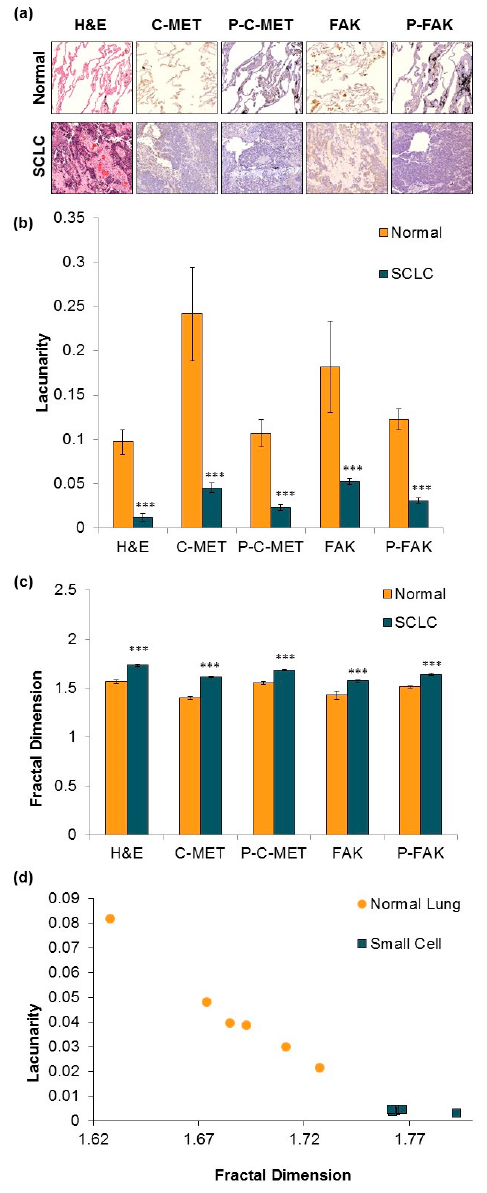
Figure 2. Immunohistochemistry images and fractal analysis of SCLC tissues. ( a ) Normal lung and SCLC tissue sections were processed for H&E and IHC staining with specific ab. ( b ) The fractal dimension of the stained normal ( n = 6) and SCLC ( n = 24) tissues was calculated using the FracLac plugin for ImageJ. Images were analyzed at 15×. Statistical significance was determined using an analysis of variance (ANOVA) with Tukey post-test. ( ∗ equals p ≤ 0.05, ∗∗ equals p ≤ 0.01, ∗∗∗ equals p ≤ 0.005). ( c ) The lacunarity of the stained normal ( n = 6) and SCLC ( n = 24) tissues was calculated using the FracLac plugin for ImageJ. Images were analyzed at 15×. Statistical significance was determined using an ANOVA with Tukey post-test. ( ∗ equals p ≤ 0.05, ∗∗ equals p ≤ 0.01, ∗∗∗ equals p ≤ 0.005). ( d ) Six areas of two formalin-fixed paraffin-embedded (FFPE) specimens (normal and SCLC) were individually analyzed and values of FD ( D B ) against lacunarity ( Λ ) were plotted for each region sampled. Images were analyzed at 40×.